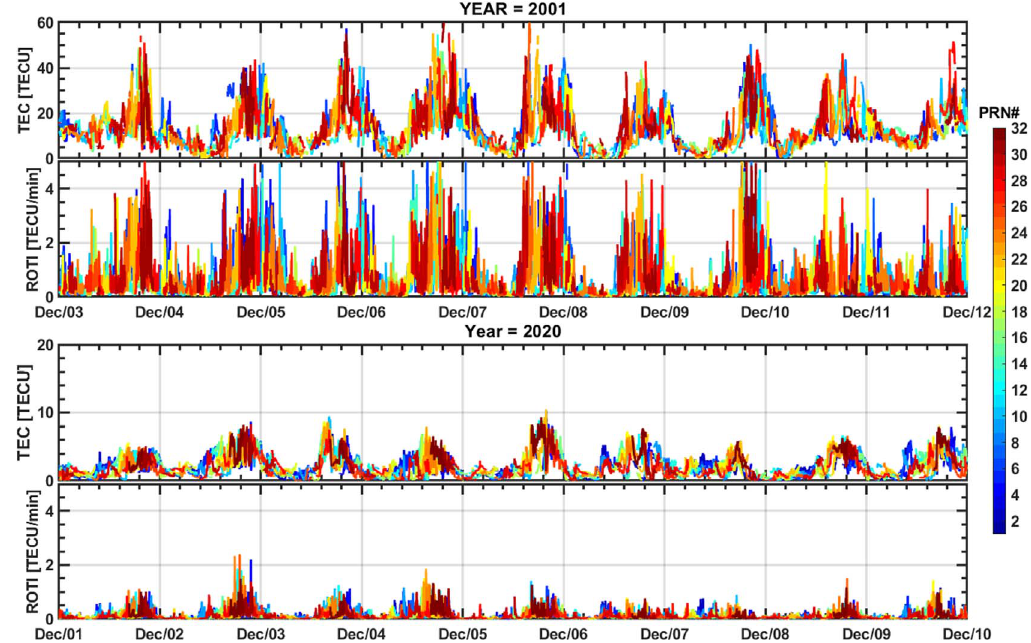
Fig. 2. Examples of vertical TEC and ROTI during different solar activities. (a – b) TEC and ROTI from December 3 to 12 near solar maximum in 2001. Different colors represent different satellites according to the PRN number in the color bar. (c – d) TEC and ROTI during 9 days near the solar minimum in